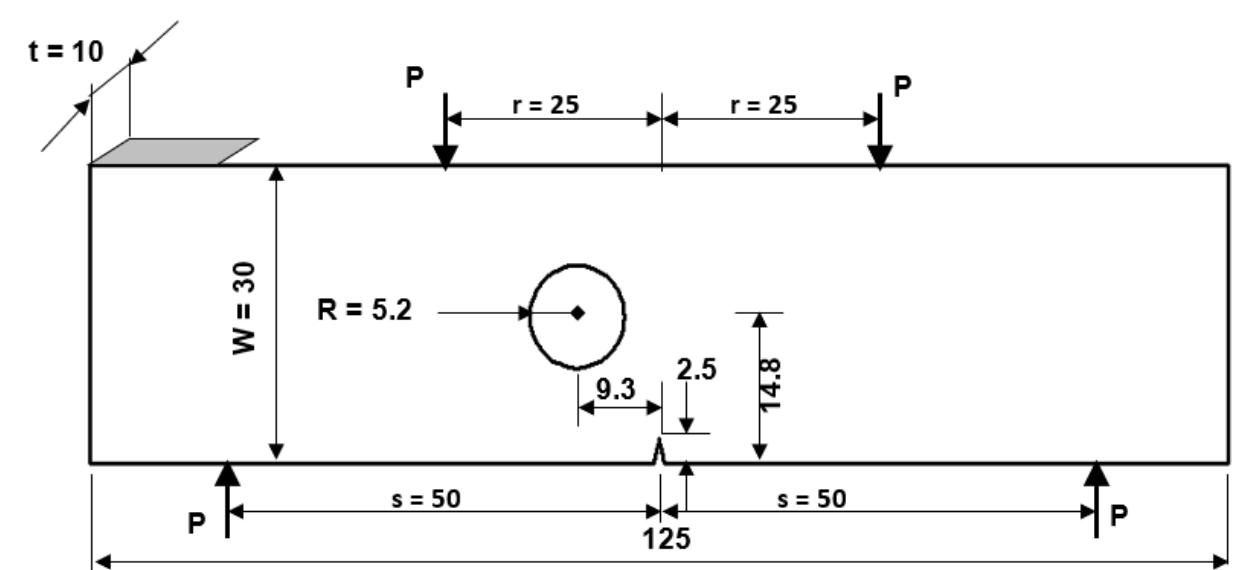
Figure 13. Geometrical dimensions and load positions of the modified four-point bending beam (mm).